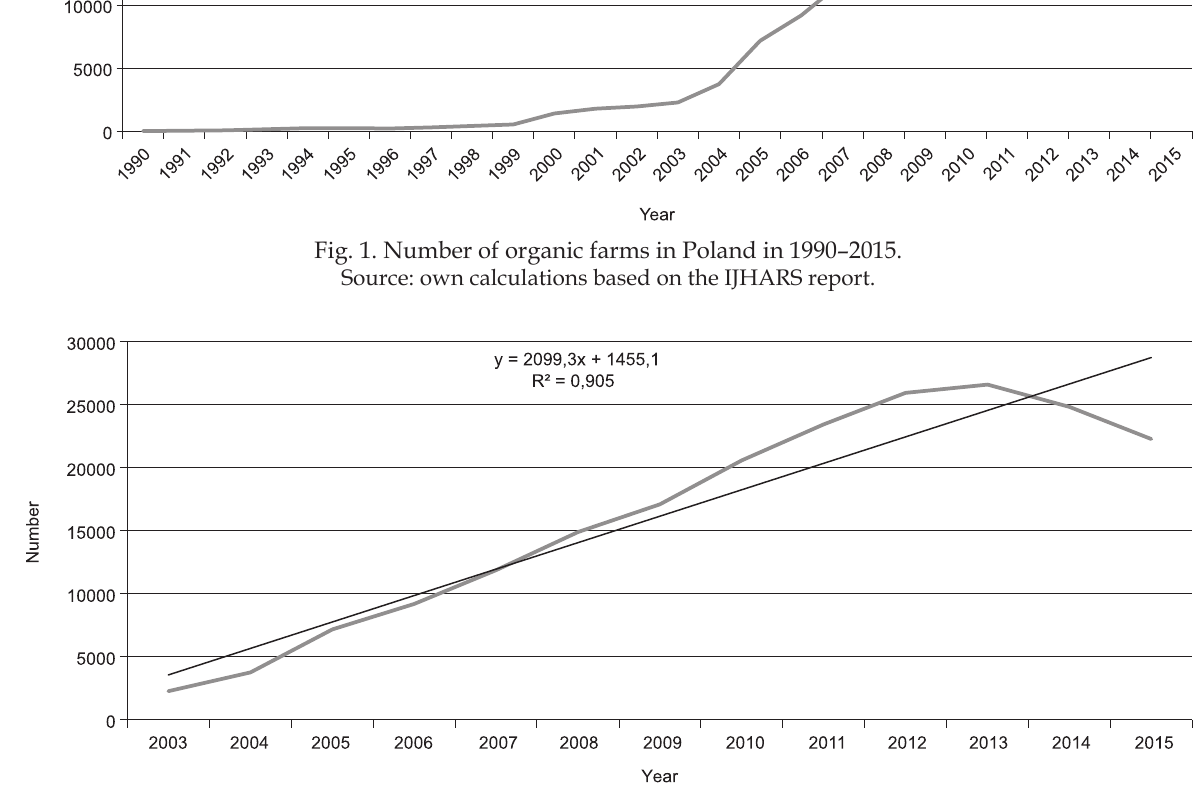
Fig. 2. Number of organic farms in Poland by voivodeship in 2003–2015. Source: own calculations based on the IJhArS